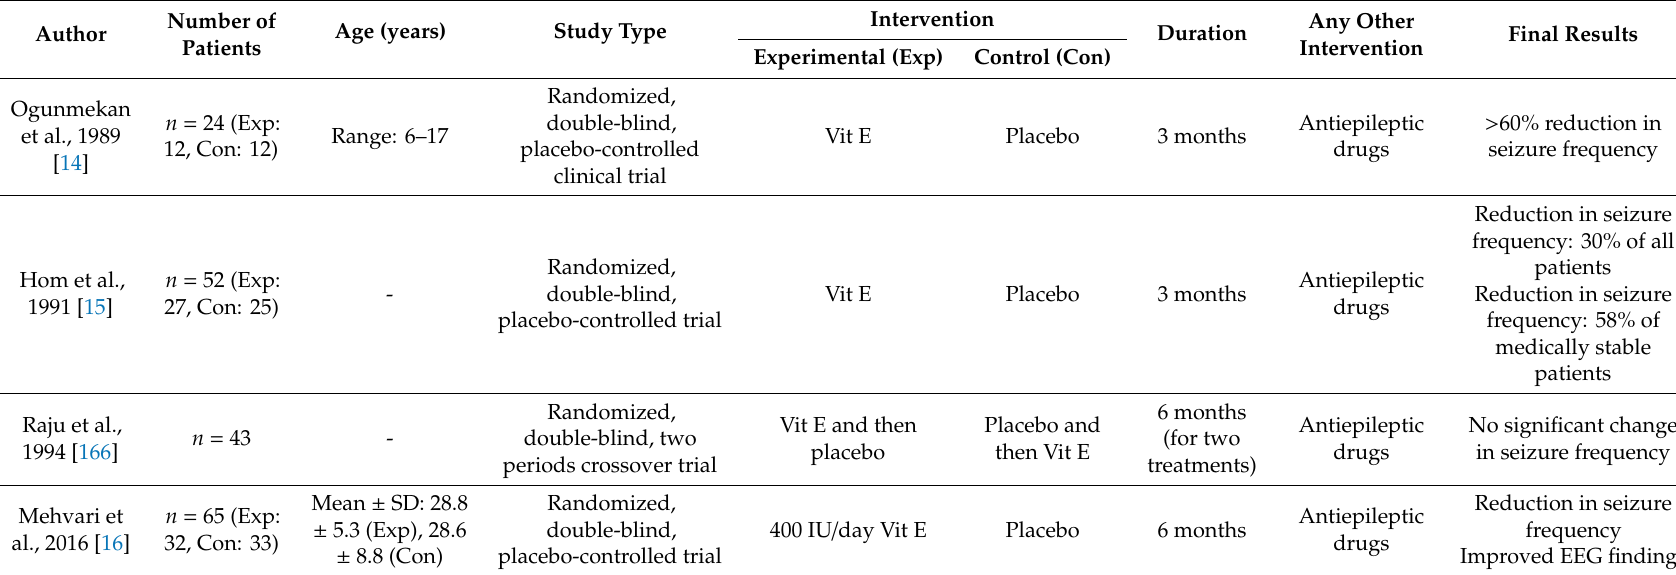
Table 3. Clinical studies assessing the e ffi cacy of vitamin E in patients with